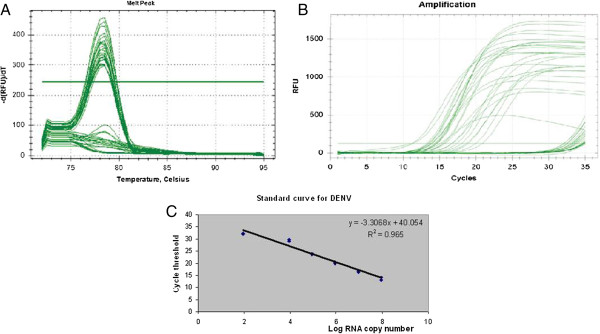
In-vitro antiviral assay via SYBR-Green RT-PCR. (A) Melt peak of DENV2. (B) Representative amplification plot for DENV2 antiviral assay. (C) Standard curve for DENV2.